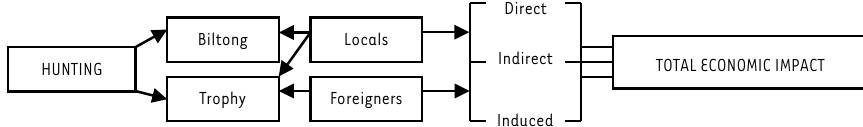
FIGURE 1: Conceptual framework for determining the economic value of hunting To estimate economic impacts, the “new money” generated for the local economy by tourism is normally considered (Gelan, 2003). Within tourism, tourists visiting a province or region usually create this “new money”. This study therefore considered revenue from both foreign and domestic hunters visiting the Limpopo Province from outside the province to represent “new money”, and excluded day excursions to the region by local people. Tourism researchers usually count as “new money” only that generated by visitors from outside the area.